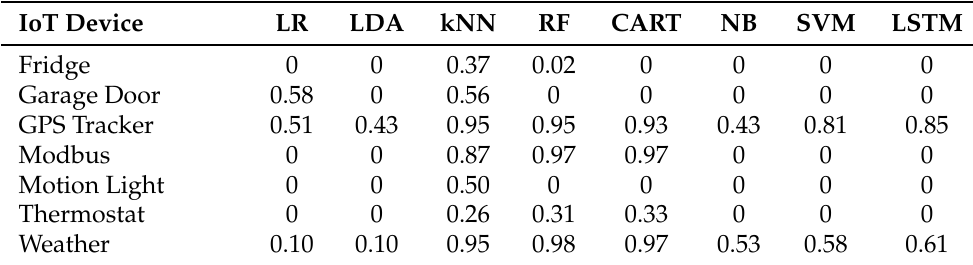
Table 2. The F-measure values for the best hyperparameters of the model trained on the TON_IoT dataset calculated for the test